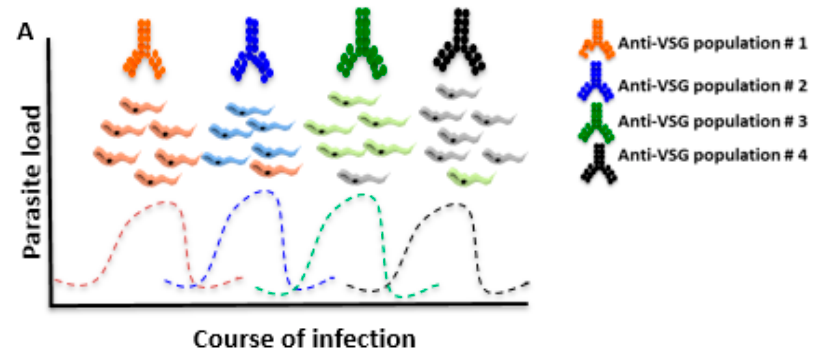
Figure 1. Host immunosuppression caused by coats change of variable surface protein (VSG). T. brucei is exclusively an extracellular parasite which constantly changes VSG to successfully evade the mammalian host’s immune system. After antibodies titer increases, the vast majority of parasites are eliminated and only parasites with different VSG coats survive. The bloodstream forms must survive as free-living by assuming a succession of proliferative and quiescent development. The VSG coat is highly antigenic and produces robust VSG-specific antibodies (Anti-VSG population), which participate efficiently in the processes of opsonization and parasite lysis mediated by the complement system. Anti-VSG antibodies contribute to the elimination of parasitic burden, however, a small proportion of the parasite population switches VSG coats, which stimulates a new antibody response to the prevalent new VSG population, and this process repeats until the immune system fails.